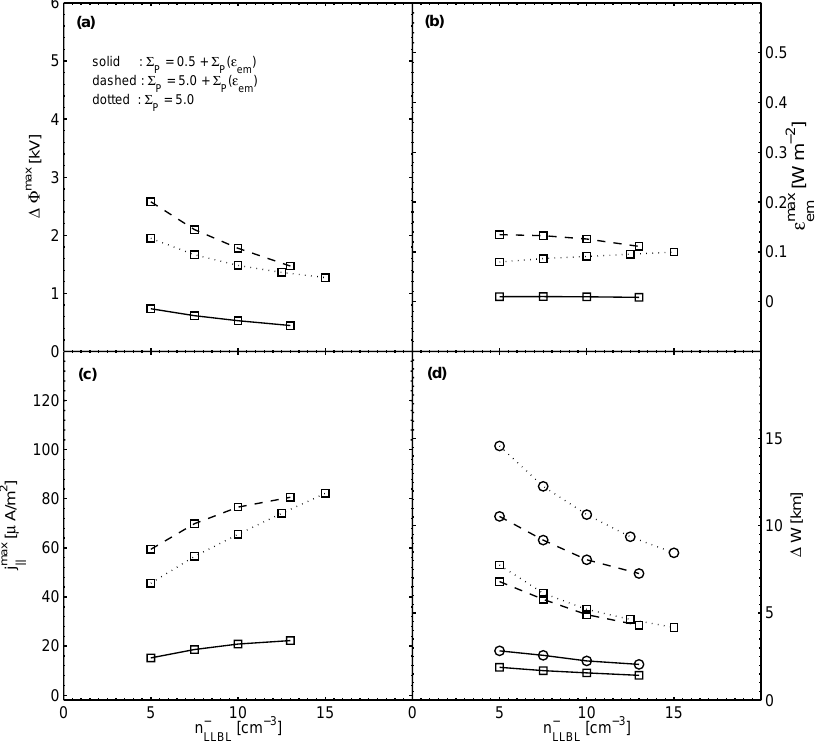
Fig. 8. Auroral arc’s characteristics as a function of: (a) the LLBL plasma density and (b) the height-integrated Pedersen conductivity. Solid lines represents results obtained for 6 P depending on (cid:15) em (see Eq. 2) with a background conductance 6 P 0 = 0 . 5; dashed lines show results obtained for a non-uniform conductance with 6 P 0 = 5 . 0S; dotted lines correspond to results obtained for a uniform Pedersen conductance, 6 P = 5S. Same scales are used as in Fig. 6 for a better comparison of the results. See also caption of Fig. 6 for a description of panel